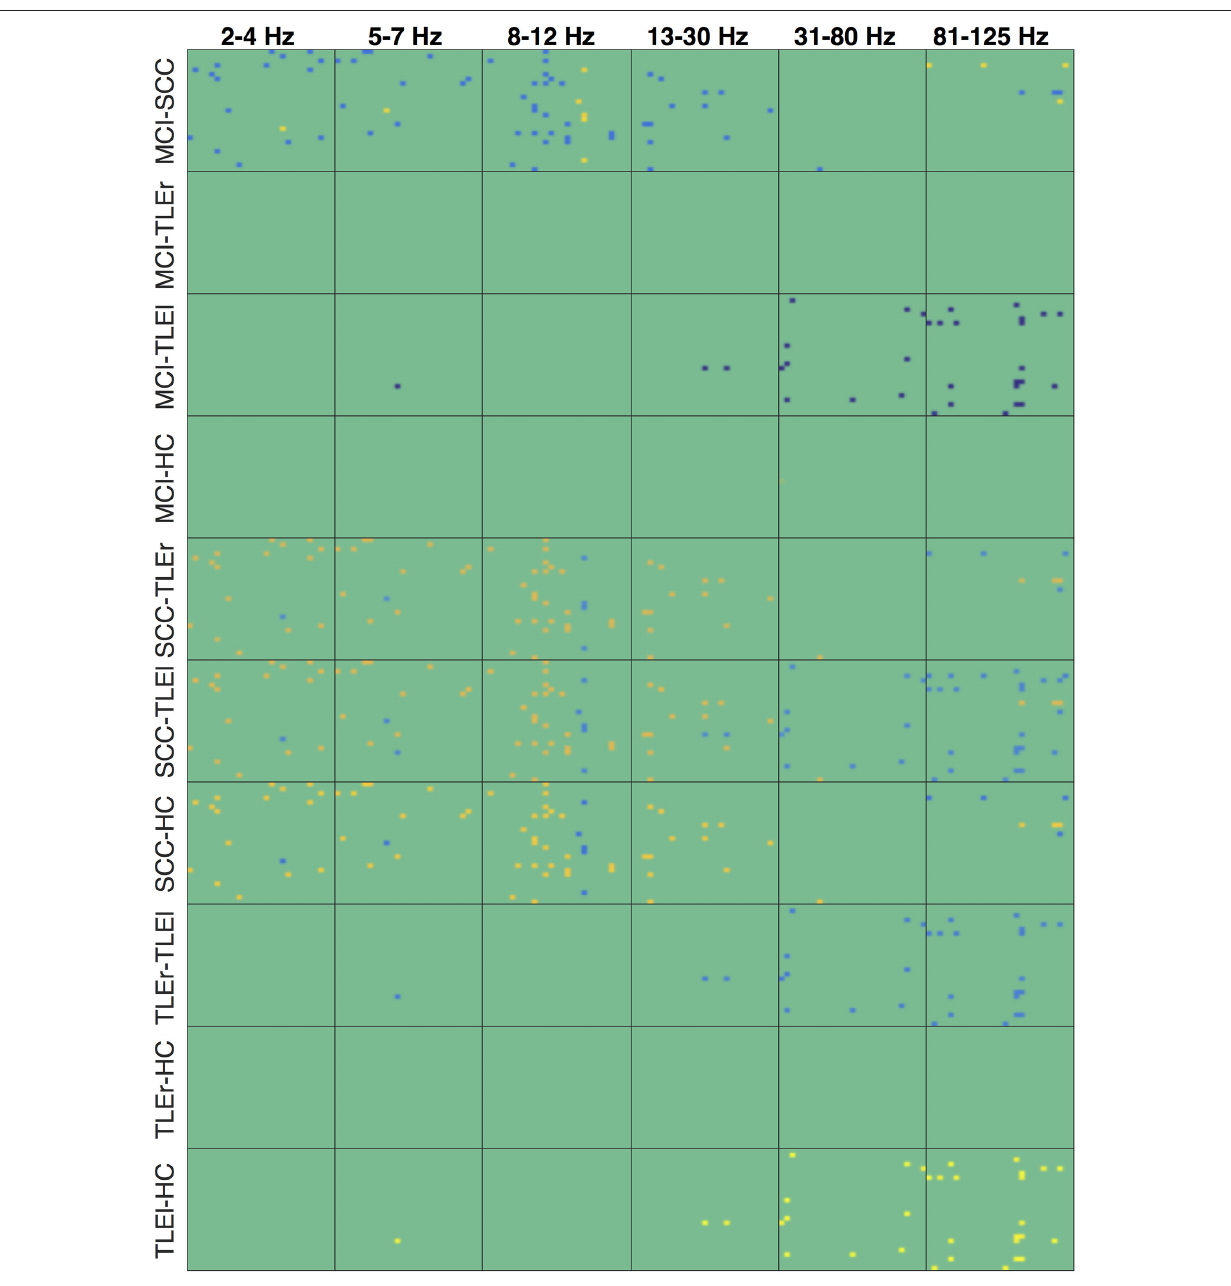
FIGURE 9 | Heatmaps of the group differences in reliability for full frequency directed transfer function. Heatmaps show the reliability of all electrode × electrode interactions for measure of interaction full frequency directed transfer function, sorted by group comparisons in rows and frequency in columns. Each of the small boxes is drawn as the network matrix with one point corresponding to a specific electrode × electrode combination. Colors indicate values from − 37.45 (dark blue) to + 32.85 (bright yellow). Not-significant differences were set to 0 and appear in green. Electrodes start from top left following the order of the list as given in Section 2.4. MCI, mild cognitive impairment; SCC, subjective cognitive complaints; TLEr, right lateralized temporal lobe epilepsy; TLEl, left lateralized temporal lobe epilepsy; HC, healthy